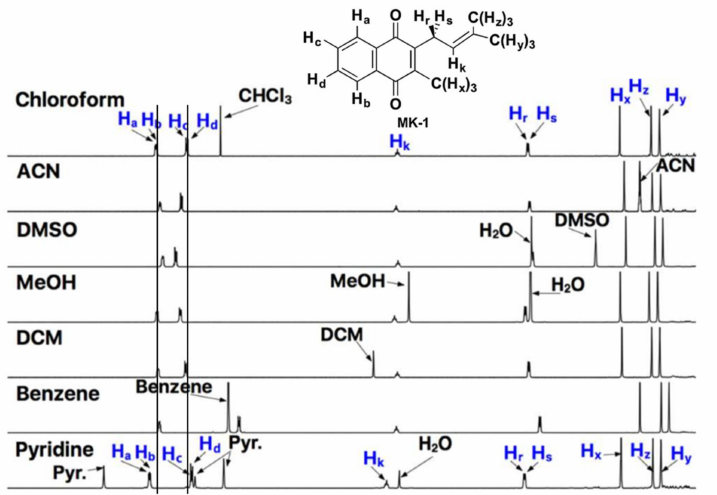
Figure 4. 1D NMR spectra of MK-1 in polar and nonpolar solvents. Lines through the aromatic protons, Ha/Hb and Hc/Hd, are provided to highlight the changes in chemical shift. Adapted with permission from Biochemistry 2019, 58, 1596–1615. Copyright 2022 American Chemical